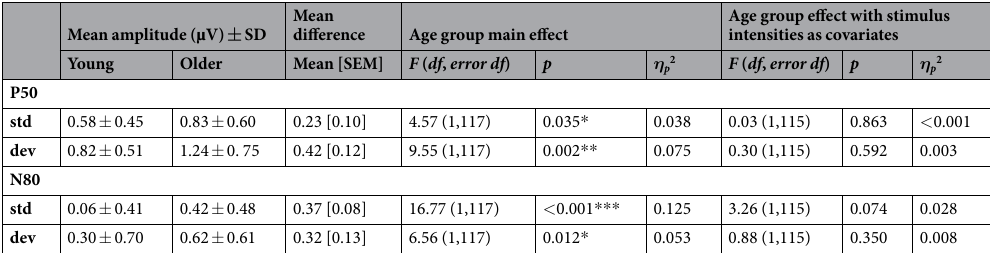
Table 1. Results of ANCOVA of early somatosensory ERP components in response to deviant and standard stimuli in younger and older adult groups. Stimulus intensities for little finger and forefinger were used as covariates. SEM, standard error of mean; SD, standard deviation; df, degrees of freedom; η p 2 , partial eta squared; p , statistical significance; * p < 0.05; ** p < 0.01; *** p < 0.001.